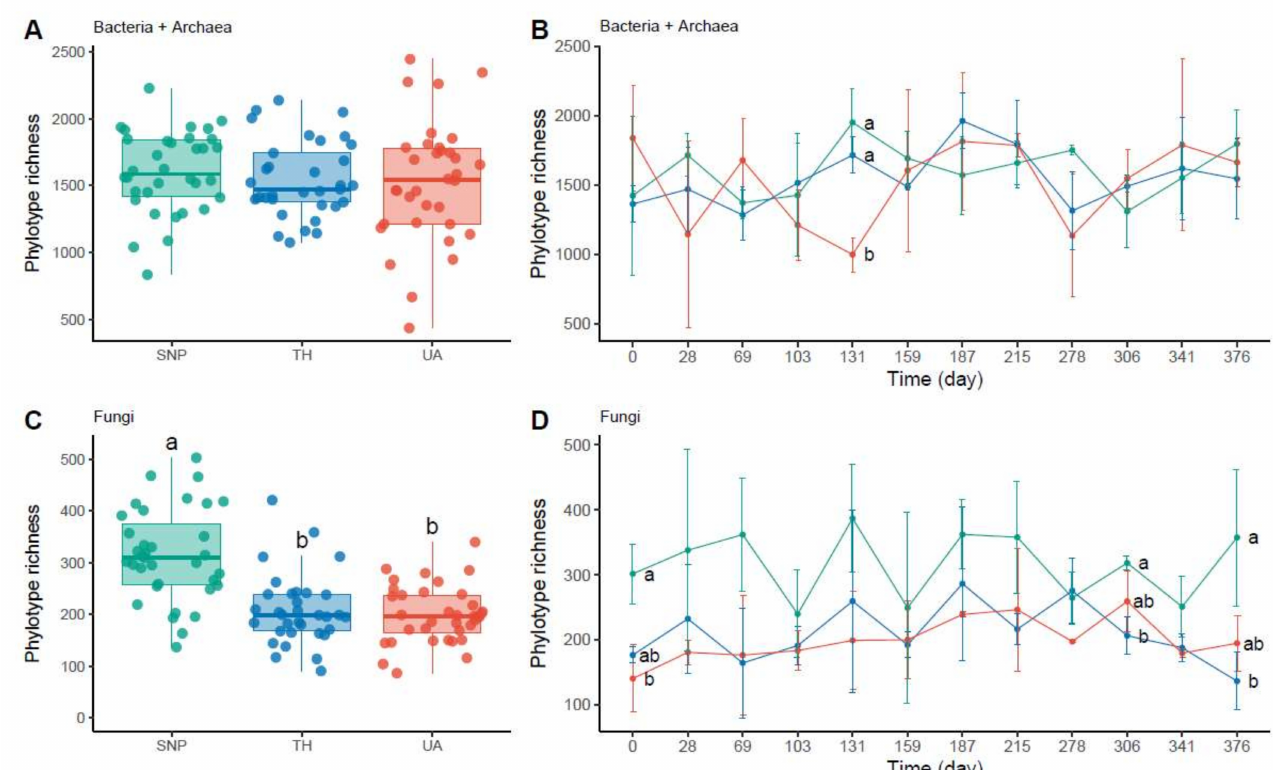
Figure 2. Changes in microbial richness across locations. Different letters indicate significant difference ( p < 0.05) based on Tukey’s HSD test. ( A , C ) Phylotype richness difference across locations. ( B , D ) Temporal change in phylotype richness. Horizontal axis denotes sampling day. Points are means of phylotype richness per day and error bars are standard deviations of the mean. Location abbreviations are the same as those in Figure